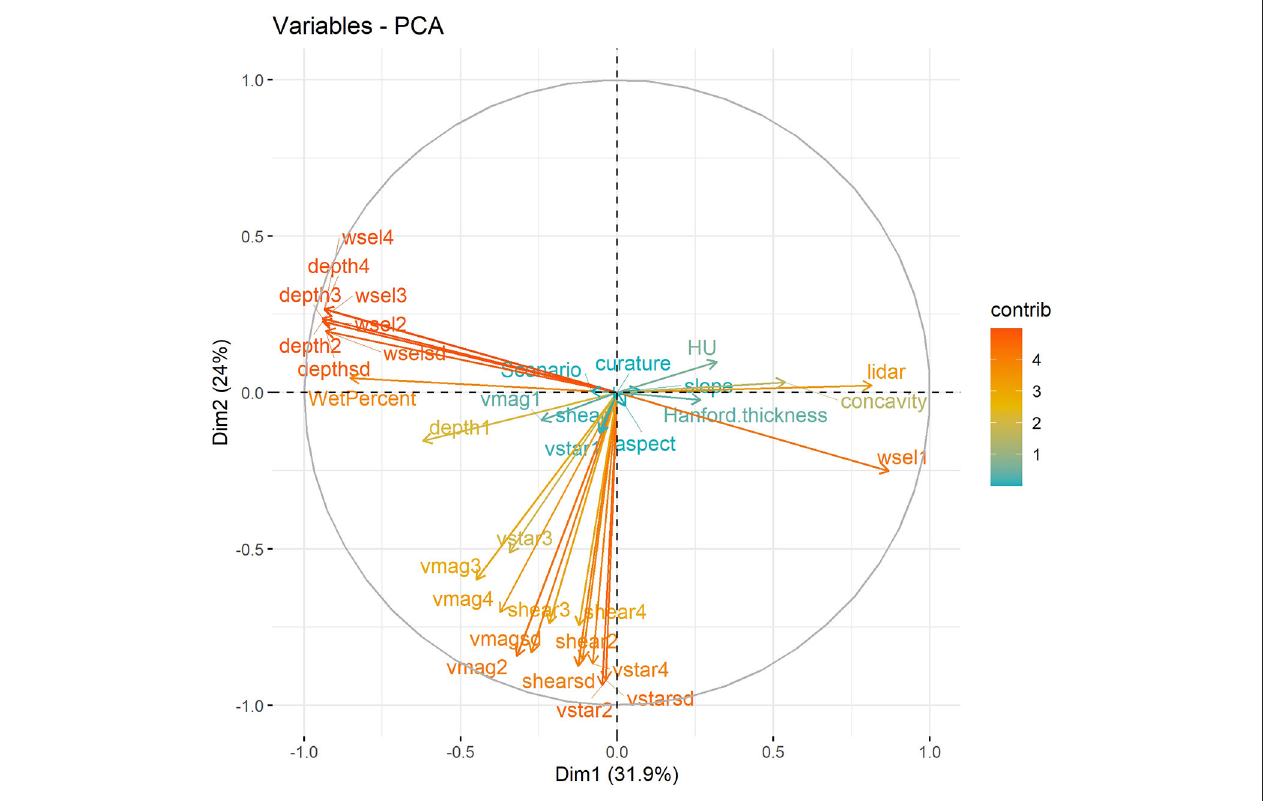
FIGURE 8 | Results of PCA analysis for the predictor variables. Dim1 and Dim2 are the first- and second- identified principal components, respectively, and the arrows show the contributions of each predictor variable to those two principal components. Together, Dim1 and Dim2 capture over 55% of the total variance of the entire